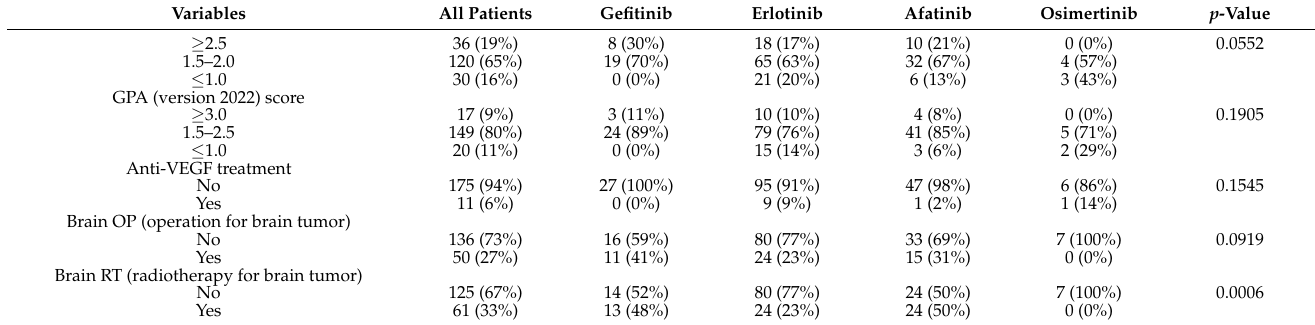
EGFR TKIs taken as the first-line systemic treatment were gefitinib (27 patients), erlotinib (104 patients), afatinib (48 patients), and osimertinib (7 patients) (Table 1). Patients receiving different EGFR TKIs were similar in age, performance status, and